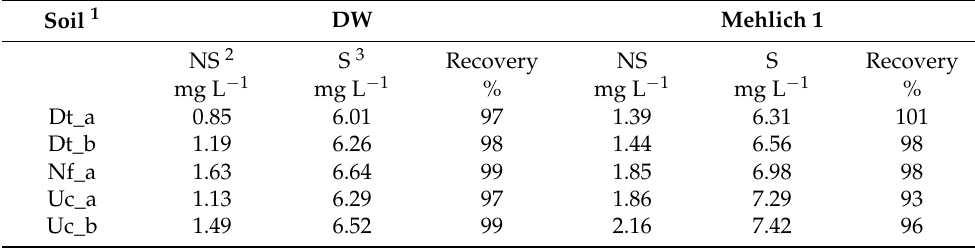
Table 2. Measurement of Phi in de-ionized water (DW) and Mehlich 1 soil extracts spiked with 5 mg L − 1